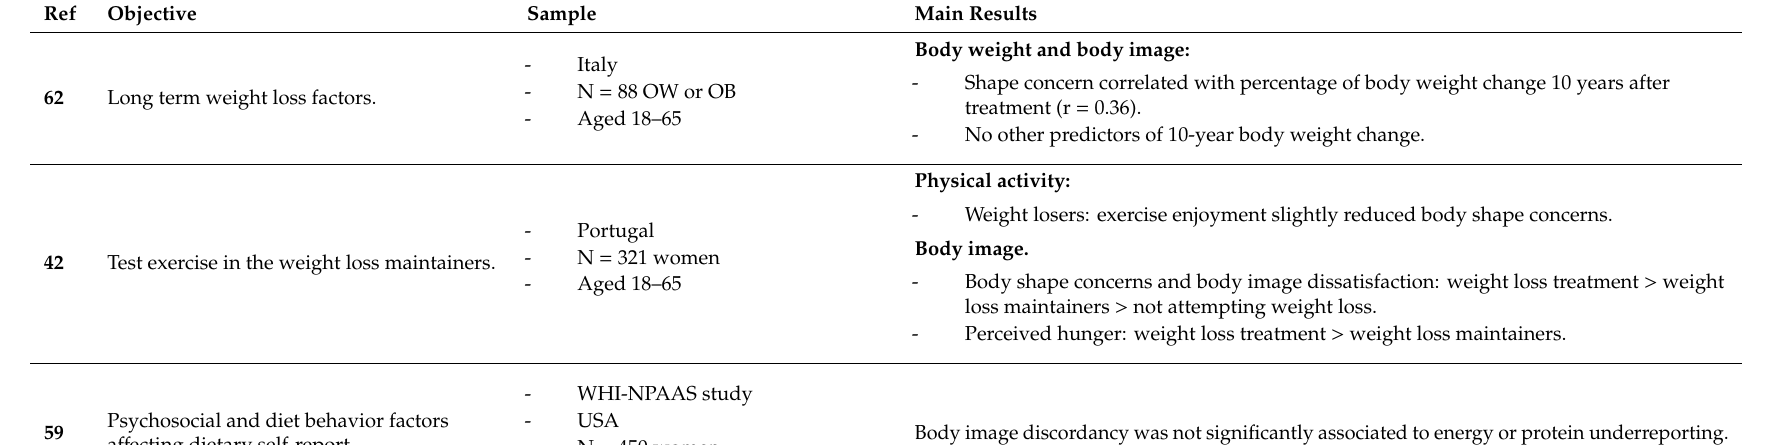
Association between BMI and dietary pattern: - Association between silhouette and dietary